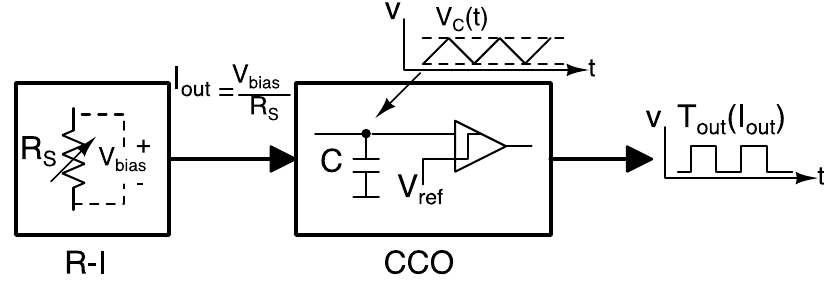
Figure 1. Block diagram of the proposed resistive sensor